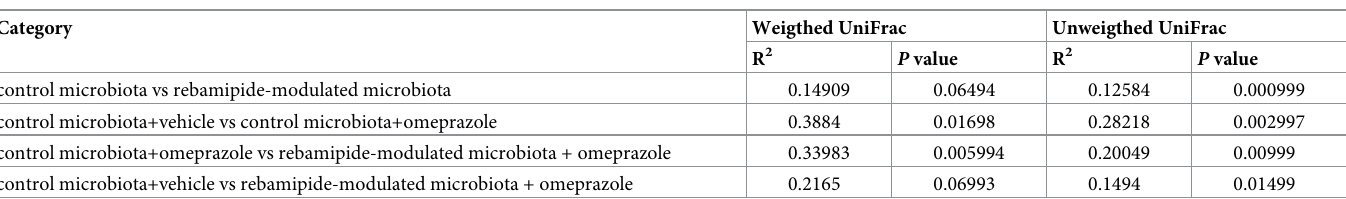
Table 2. PERMANOVA of UniFrac distance in small intestine.